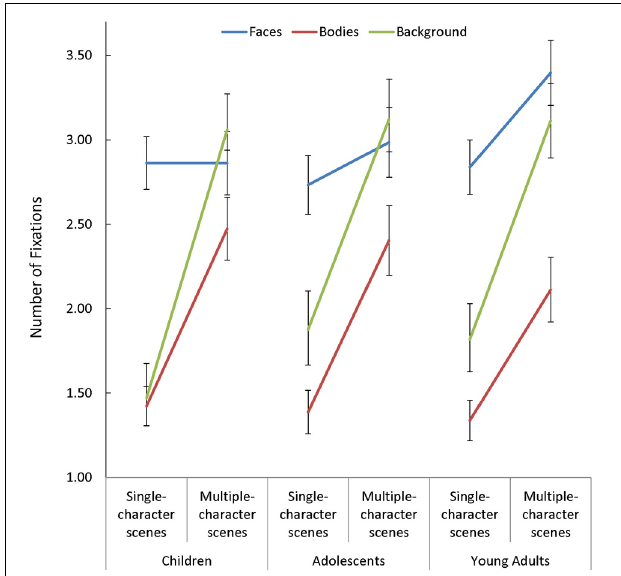
FIGURE 3 | The number of fixations made by children, adolescents, and young adults within the each area of interest (AOI; faces, bodies, and backgrounds) for single- and multiple-character scenes.